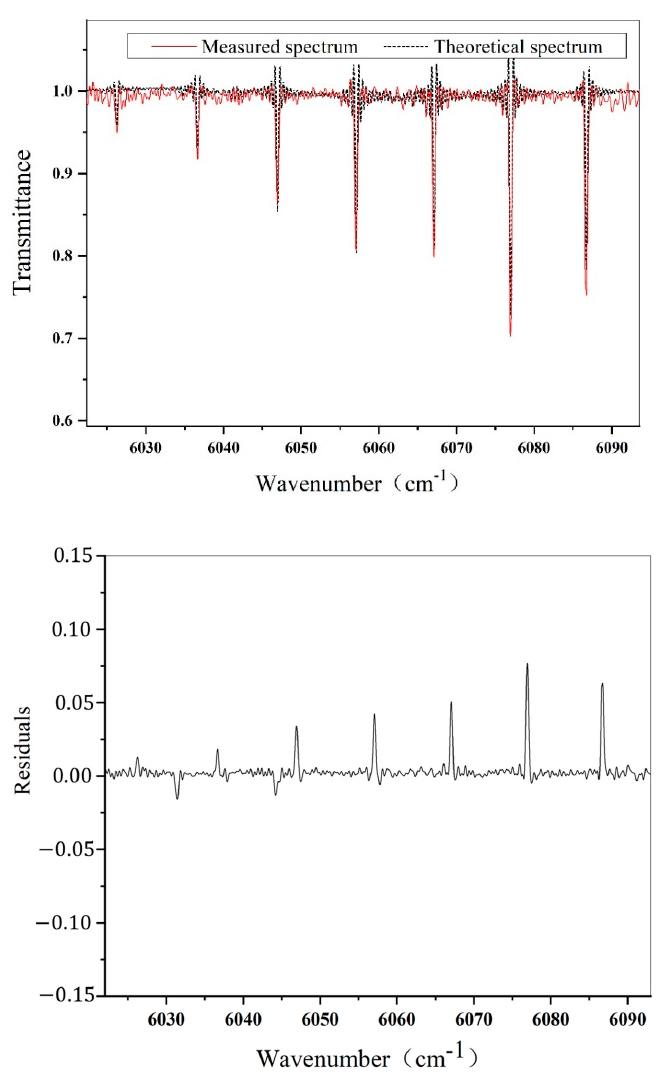
Figure 8. Test data of absorption spectral transmittance of CH 4 spectral channel.